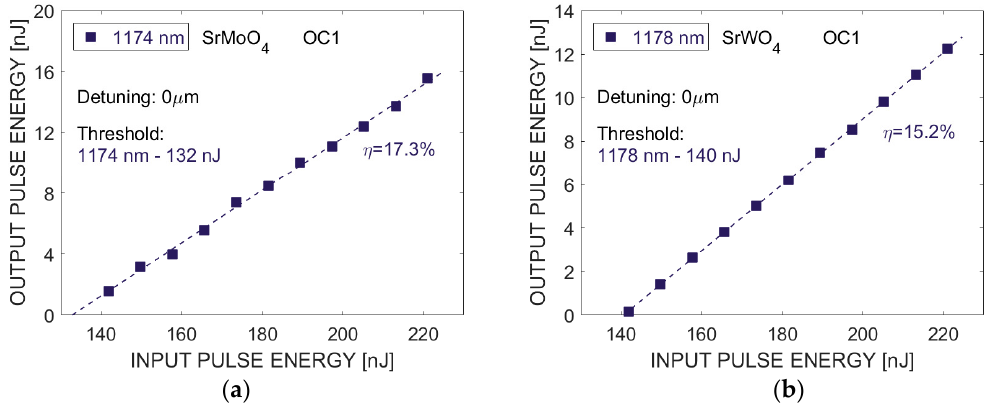
Figure 6. The output SRS pulse energy as a function of the input pump pulse energy in the ( a ) SrMoO 4 [88] and ( b ) SrWO 4 Raman lasers at the output coupler OC1 for the case of perfect synchronization.